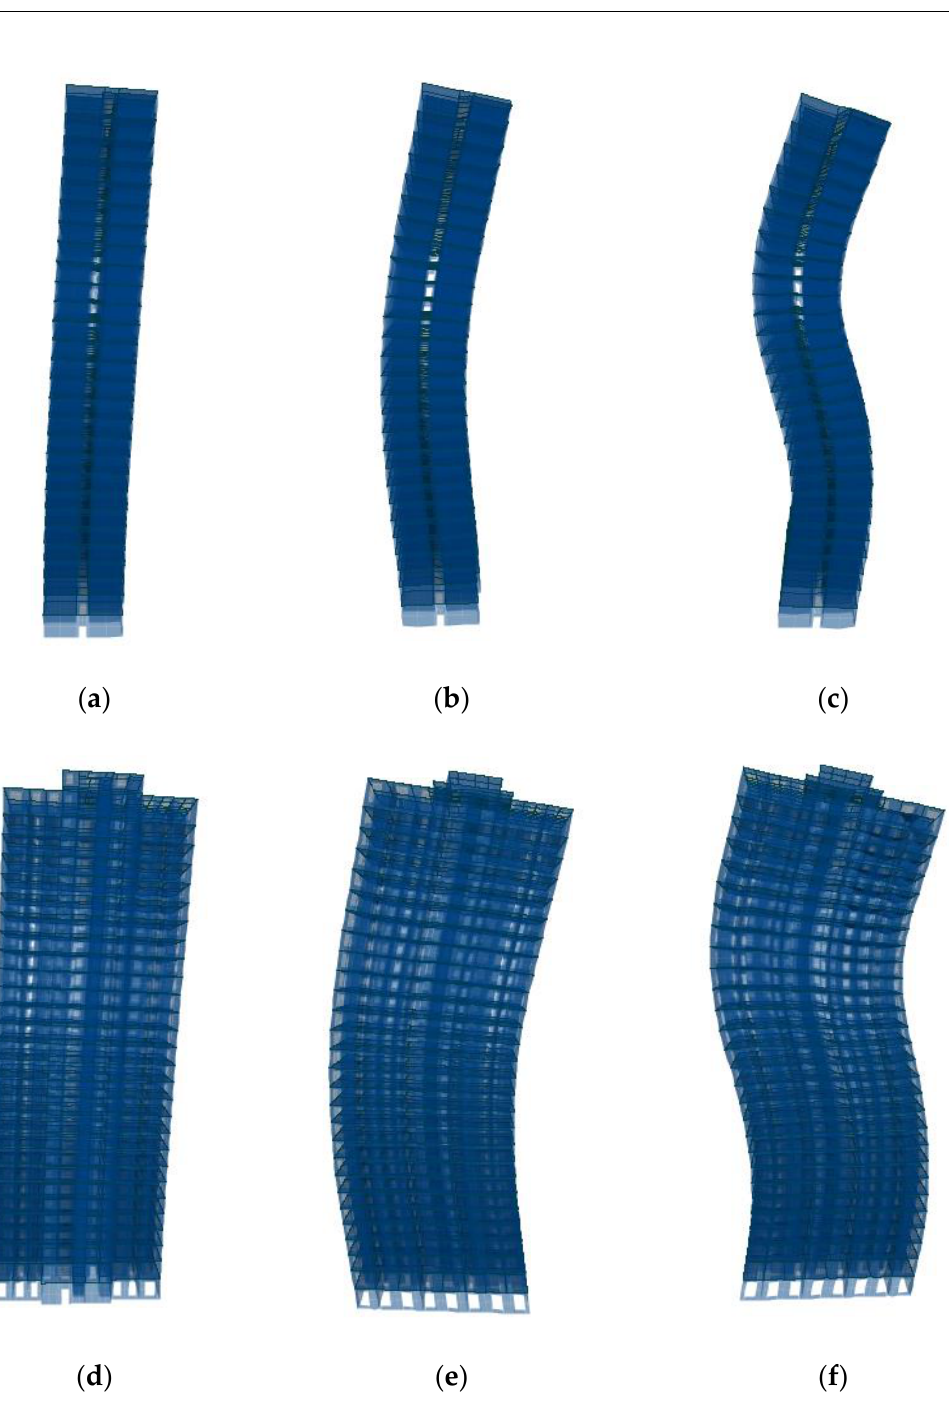
Figure 9. The mode shapes of the structures from the numerical analysis. ( a ) first-order in NS, ( b ) second-order in NS, ( c ) third-order in NS, ( d ) first-order in EW, ( e ) second-order in EW, ( f ) third- order in EW.